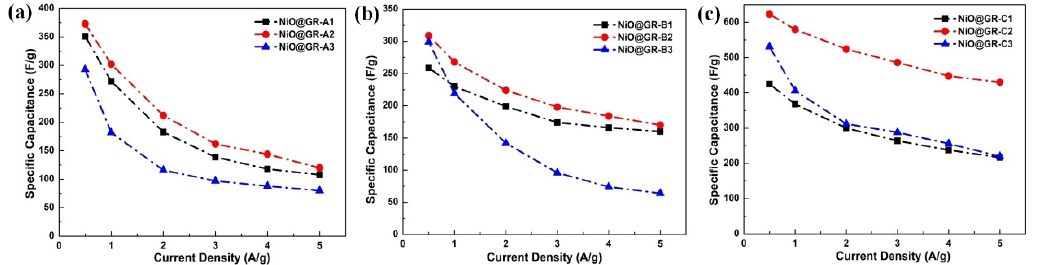
Figure 3. Specific capacitance of the NiO x @GR nanocomposites at different current densities: ( a